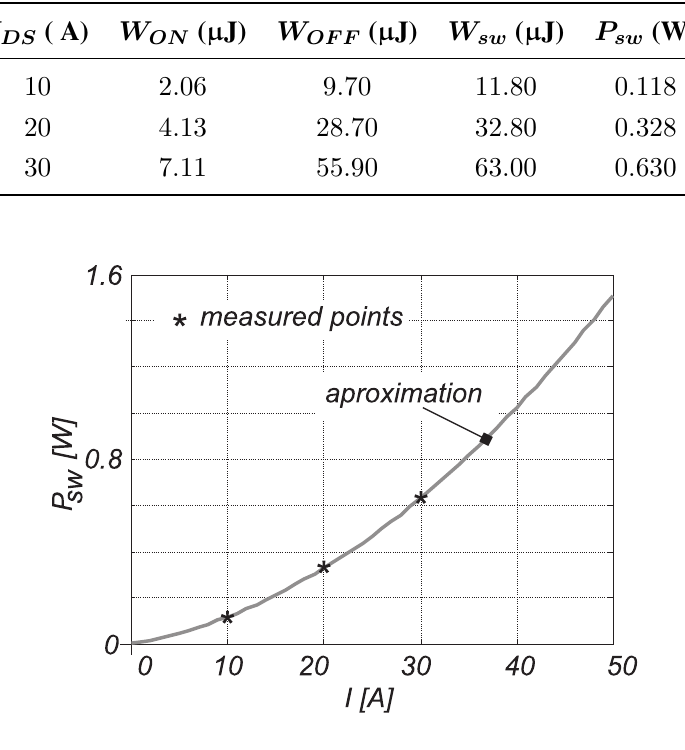
Figure 8. The MOS-FET’s switching